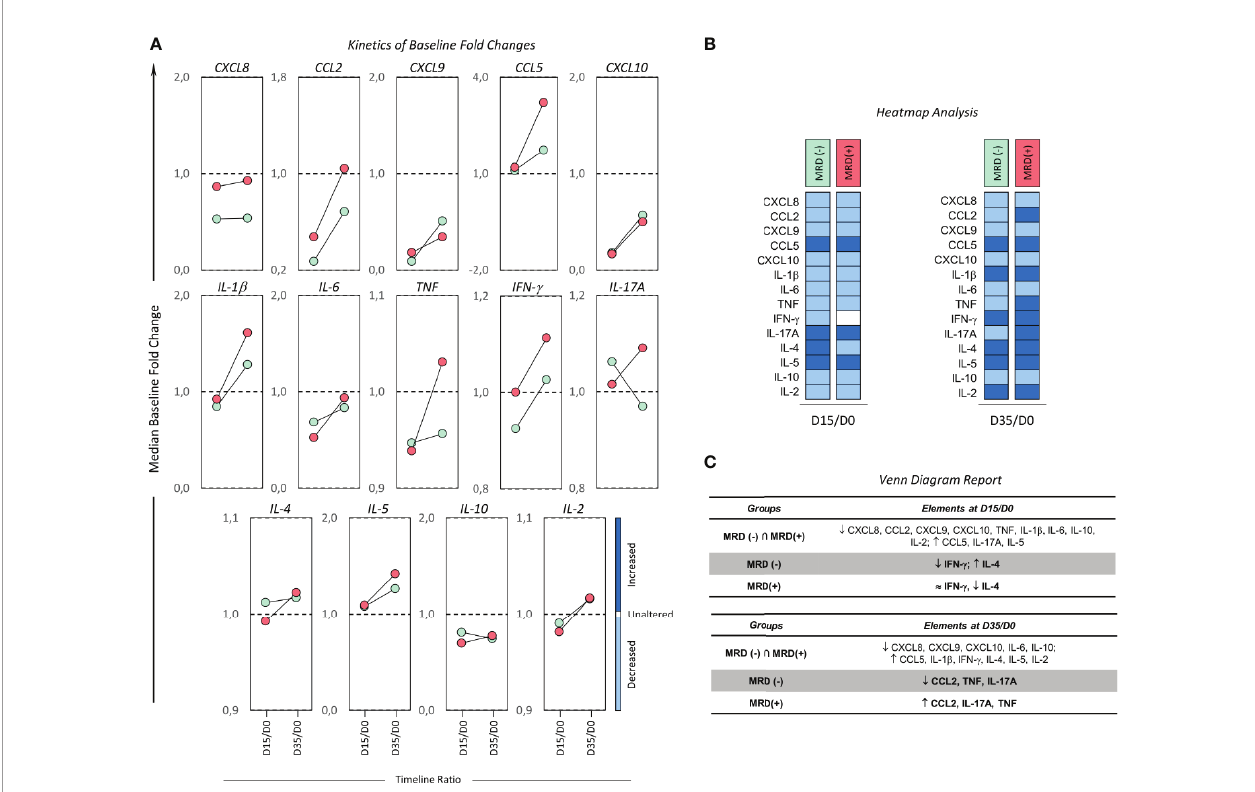
FIGURE 6 | Kinetics of baseline fold changes on bone marrow soluble mediators from B-ALL patients according to minimal residual disease detection. (A) The median ratio of biomarker levels detected on D15 and D35 in relation to the baseline was determined for B-ALL patients categorized according to the minimal residual disease detection on D35 of induction therapy, as follows: MRD (-) ( ) and MRD (+) ( ) subgroups. Changes in biomarker levels on D15 and D35 were analyzed since they exhibited: increased (baseline fold >1), unaltered (baseline folds=1) or decreased (baseline fold <1) levels in relation to D0. (B) The heat map compiles the changes in bone marrow biomarkers to identify the behavior patterns of soluble mediators in clinical subgroups. (C) Venn diagrams identify common and selective biomarkers for each clinical